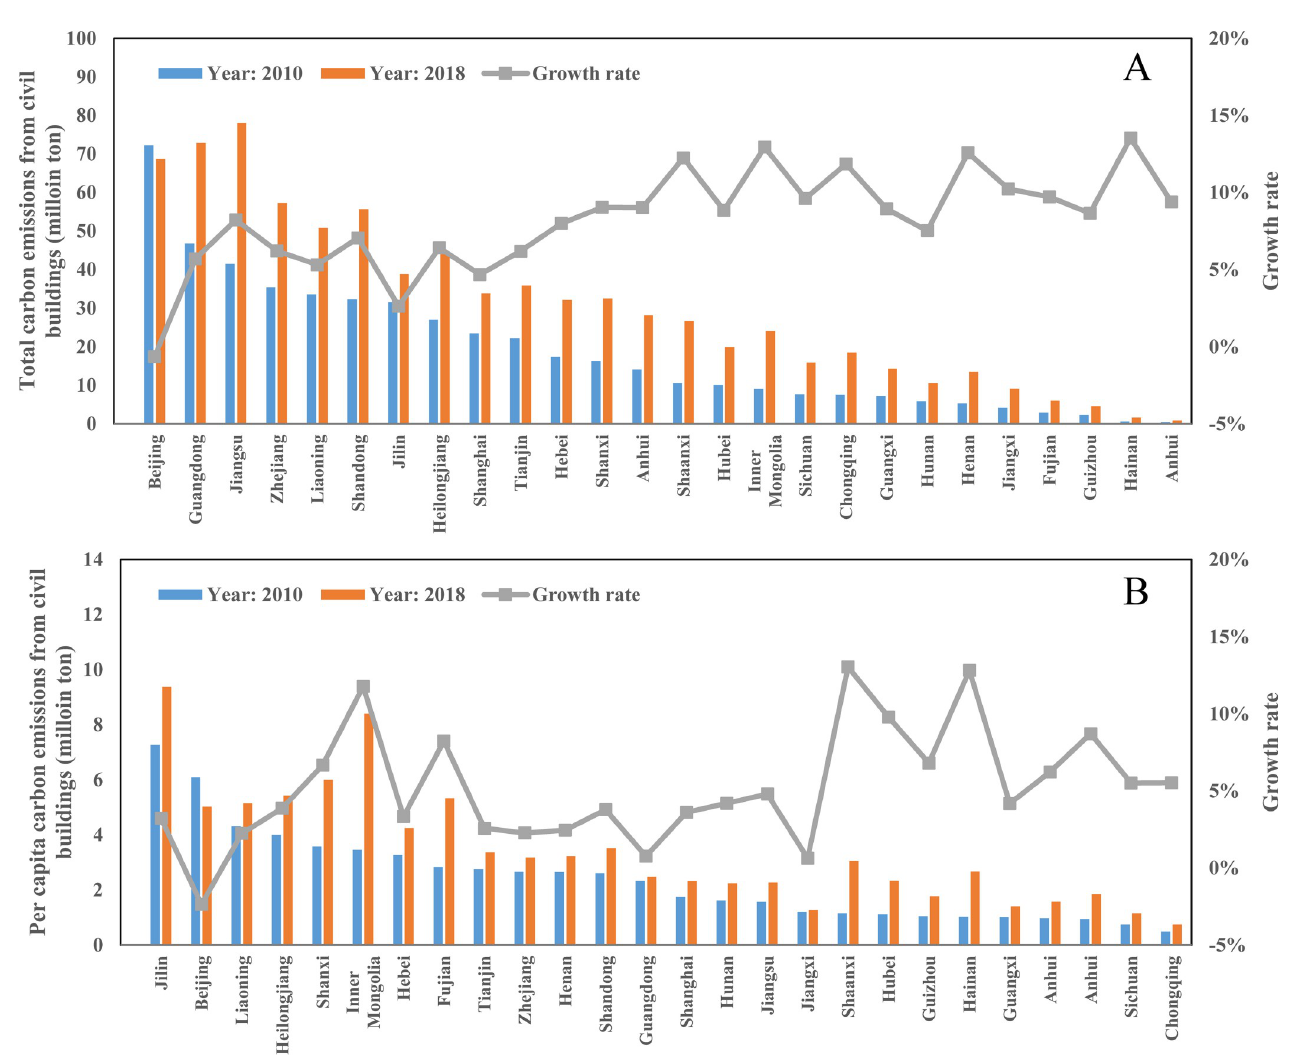
Fig 3. The temporal trend of total carbon emissions from civil buildings (A) and per capita carbon emissions from civil buildings (B) in Chinese